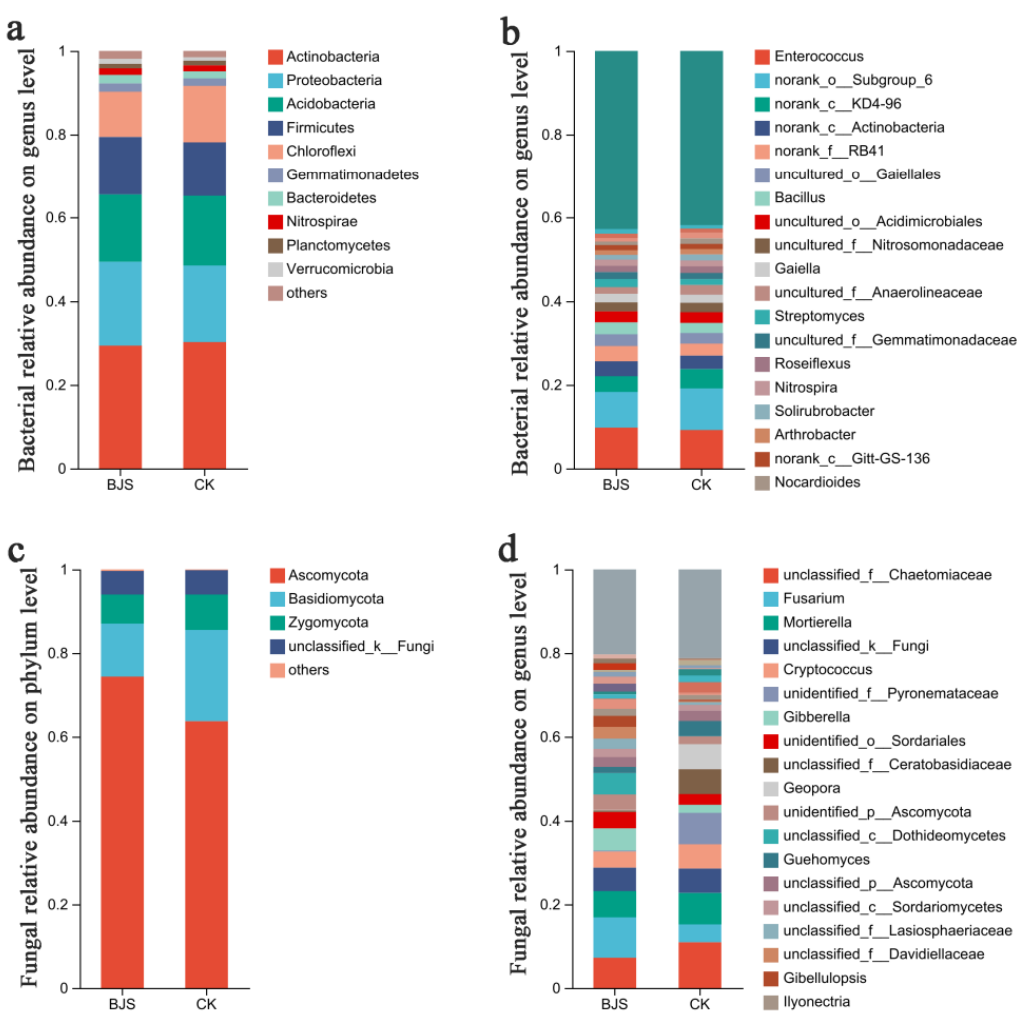
Figure 3. Bacterial and fungal communities in studied groups. ( a ) Bacterial relative abundance at phylum level; ( b ) Bacterial relative abundance at genus level; ( c ) Fungal relative abundance at phylum level; ( d ) Fungal relative abundance at genus level. An illustration of the relative abundances of major members in stacked bar graphs. “BJS” means BJS-1-3 fermentation-broth-treated poplar group; “CK” means sterilized fermentation-broth-treated poplar group. For each treatment, three replicates were analyzed.